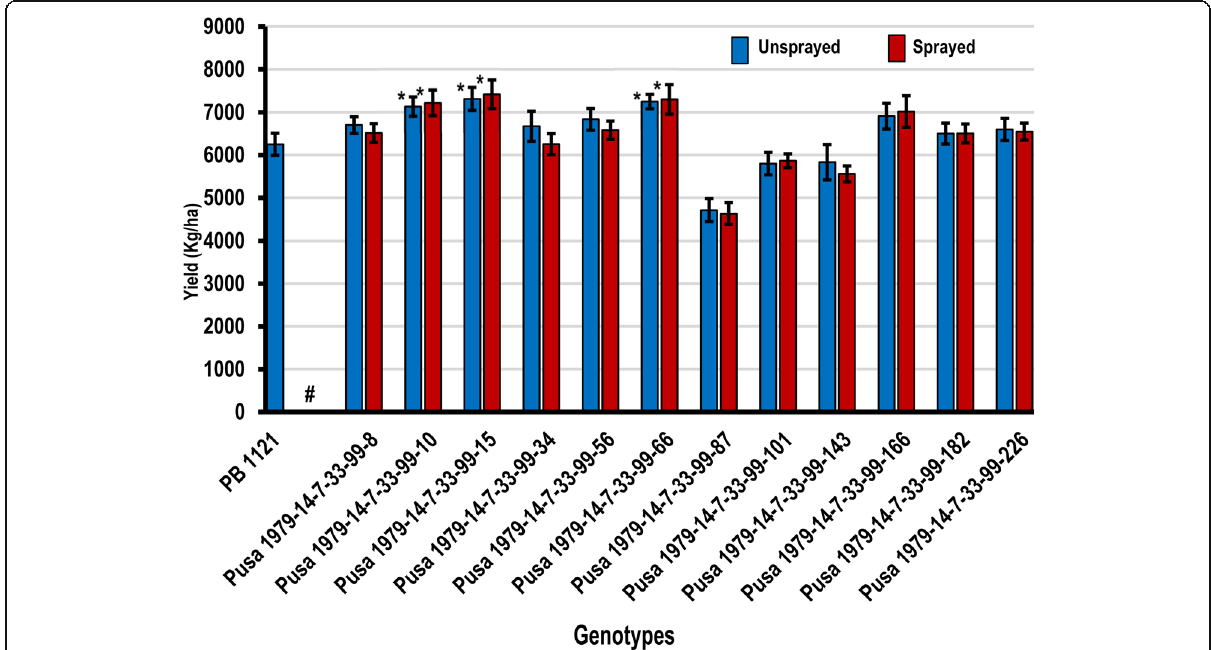
Fig. 8 Comparison of yield (kg/ha) between PB 1121 HT-NILs and their parents in unsprayed and herbicide sprayed condition; #PB 1121 seedling did not survive Imazethapyr spray; *Significantly superior to the recurrent parent, PB 1121